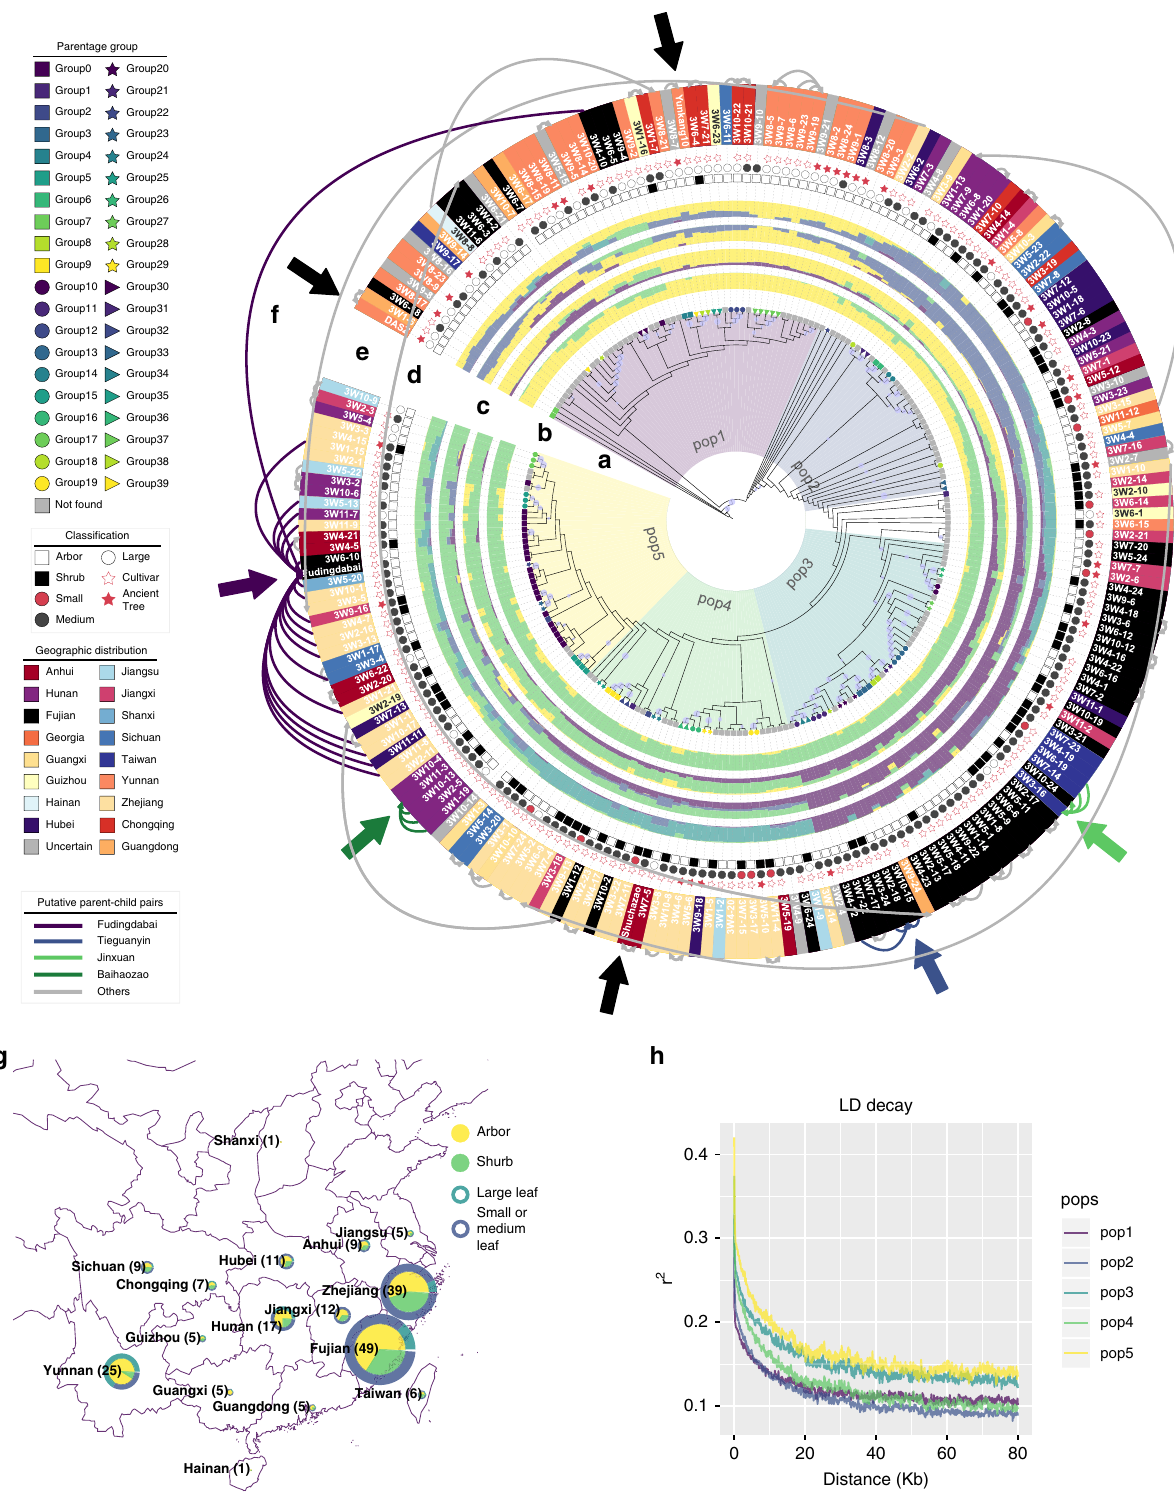
Data 10). Out of the nine compounds, fi ve showed signi fi cantly higher levels in YL compared with in TL and ML, and